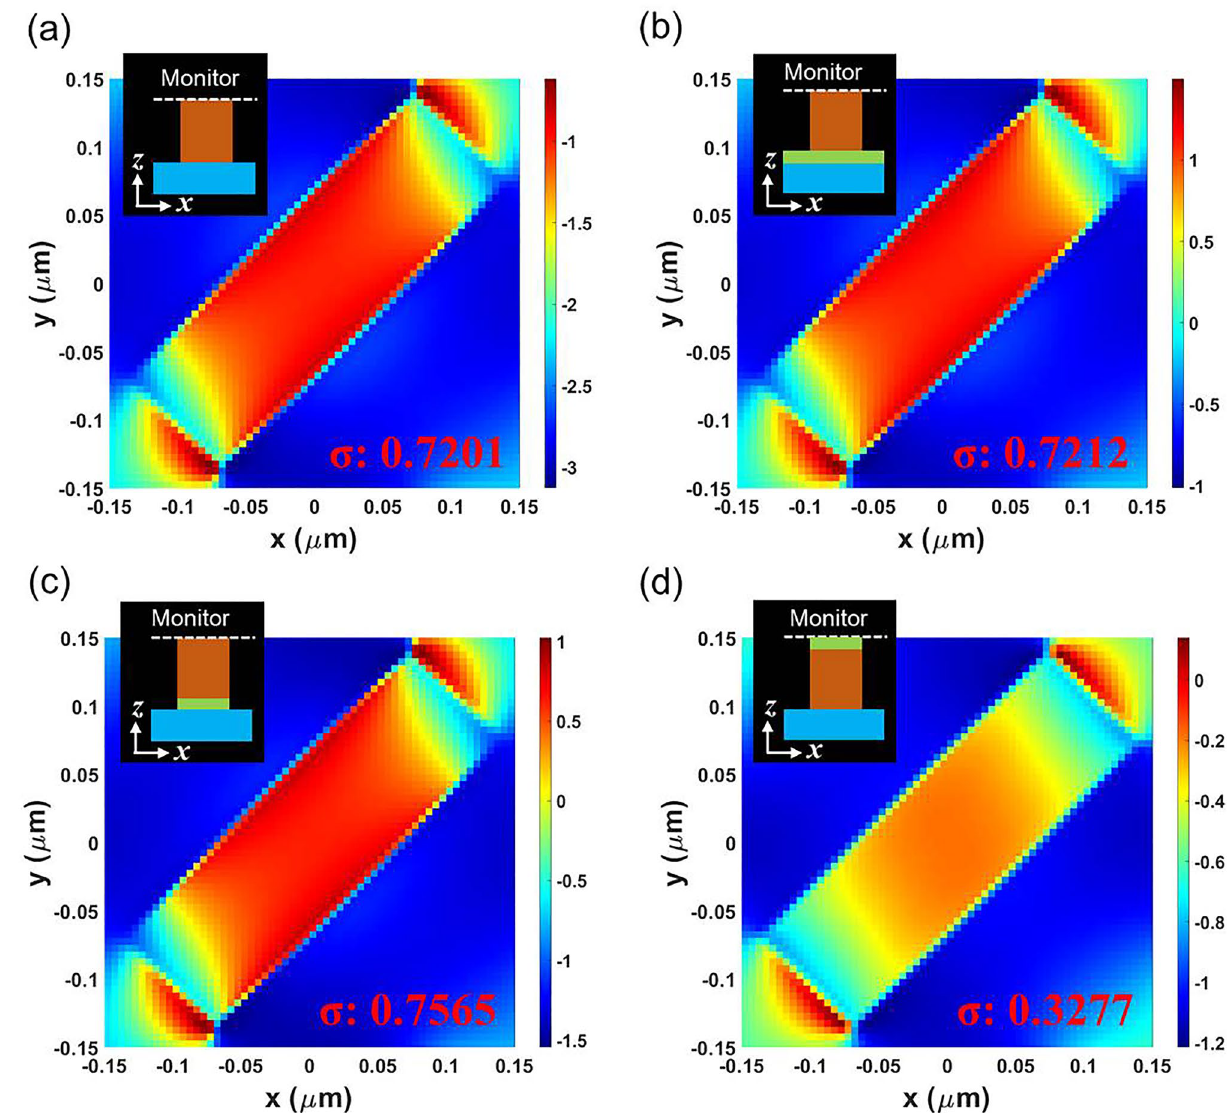
Figure 3. Electric field distribution of nano-fin structures. Simulations of phase distribution at the upper interface of the nano-fin for the ( a ) nano-fin without MgF 2 , ( b ) flat MgF 2 film, ( c ) nano-fin stacking on